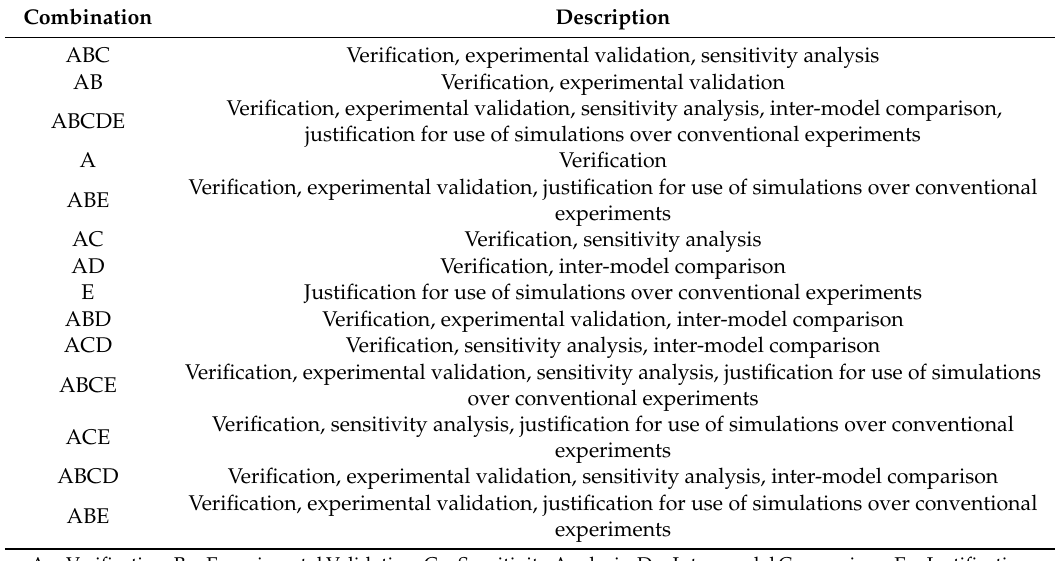
Table 3. Epistemic Strategy